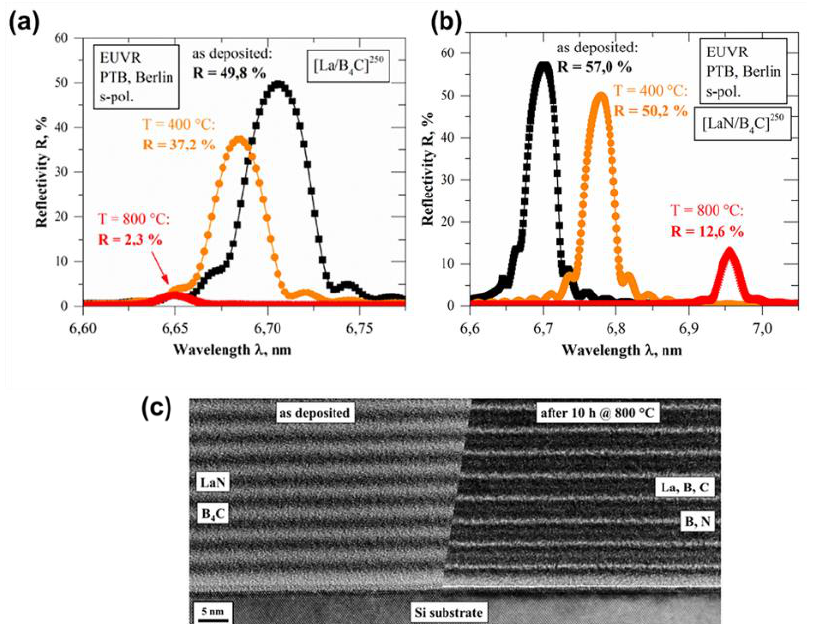
Figure 10. ( a ) EUV spectral of the La/B 4 C PMMs after deposition and after annealing at 400 and 800 °C. ( b ) EUV spectral of the LaN/B 4 C PMMs after deposition and after annealing at 400 and 800 °C for 10 h. ( c ) High-resolution TEM cross-sectional images of the LaN/B 4 C PMMs after deposition (left) and after annealing at 800 °C (right). Reprinted from [64] with permission from Elsevier.